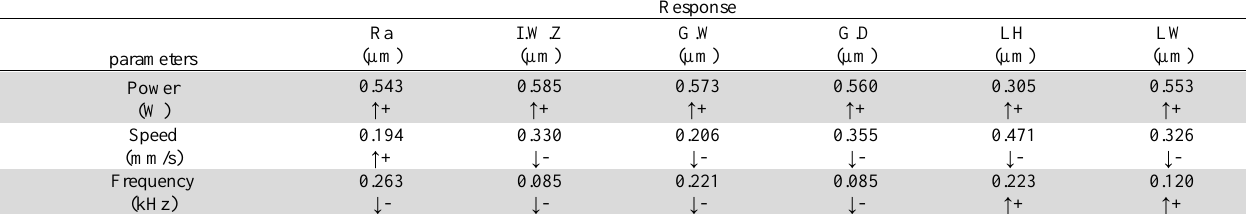
The effect of parameters on the response